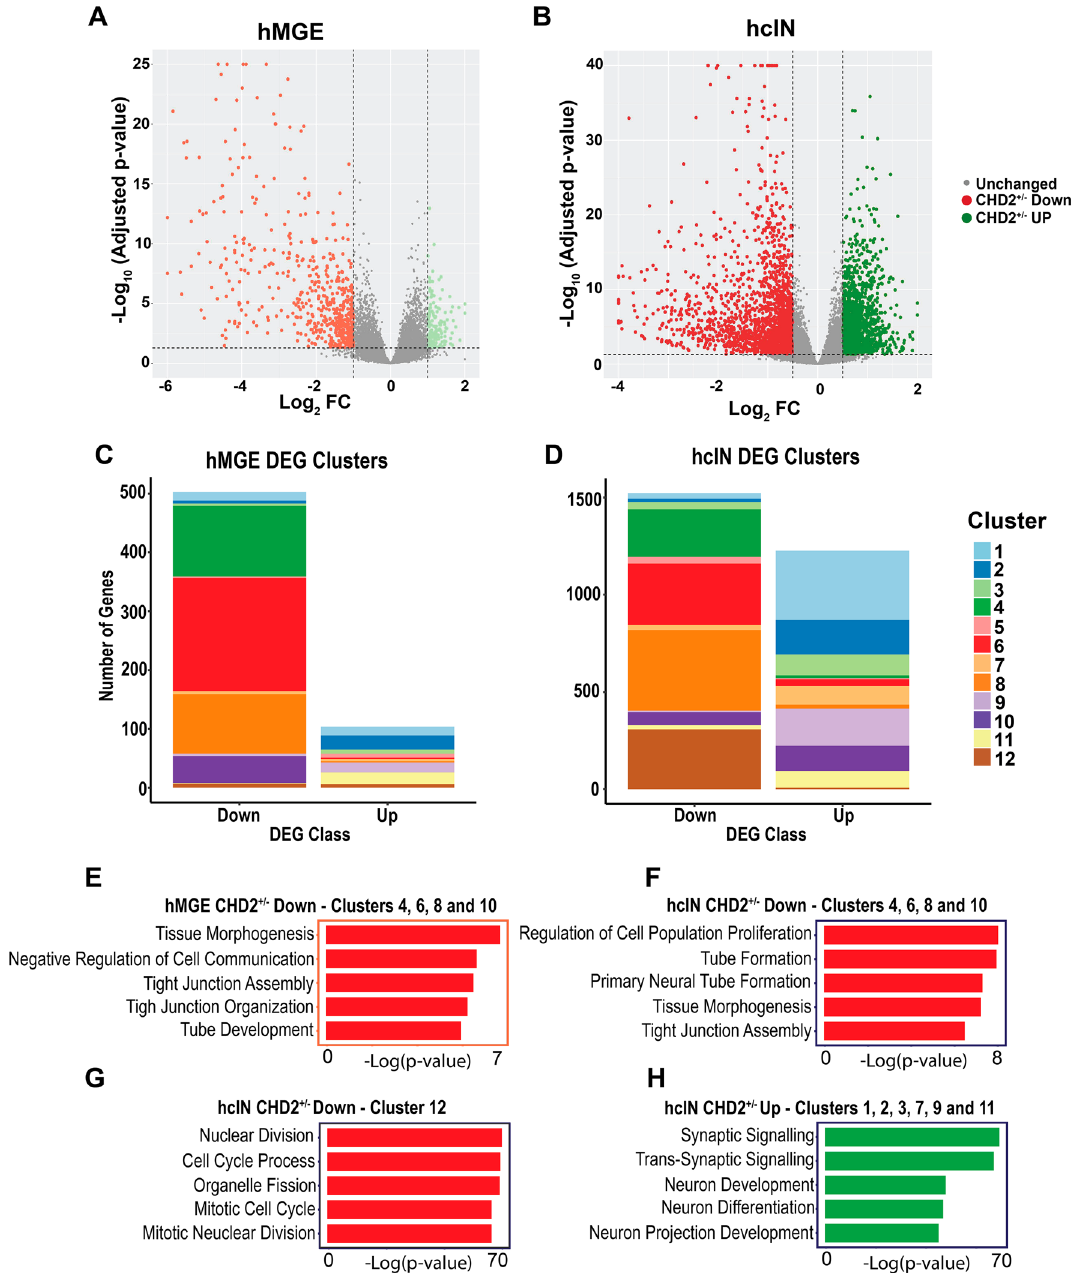
Figure 5. Gene expression changes in hMGEs and hcINs with CHD2 haploinsufficiency. ( A , B ) Gene expression differences (log2 FC) between wild type (WT) and mutant (CHD2 +/− ) in ( A ) hMGEs and ( B ) hcINs. Red: down-regulated genes in the mutant (CHD2 +/− ); green: up-regulated genes in the mutant (CHD2 +/− ). ( C , D ) Distribution across the 12 previously identified WT gene expression clusters for differentially expressed genes (DEGs) obtained in WT versus CHD2 +/− comparisons at the ( C ) hMGE and ( D ) hcIN stage. ( E – G ) Gene ontology (GO) enrichment analysis of DEGs down regulated in CHD2 +/− compared to WT models at the ( E ) hMGE or ( F , G ) hcIN stage. For hcINs, DEGs that mapped to WT expression ( F ) clusters 4, 6, 8 and 10, versus ( G ) cluster 12 were analyzed separately. ( H ) Gene ontology (GO) term analysis of DEGs that were upregulated in the CHD2 +/− compared to the WT model at the hcIN